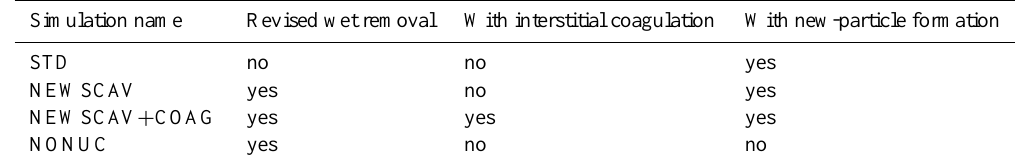
Table 1. Summary of the simulations conducted for this